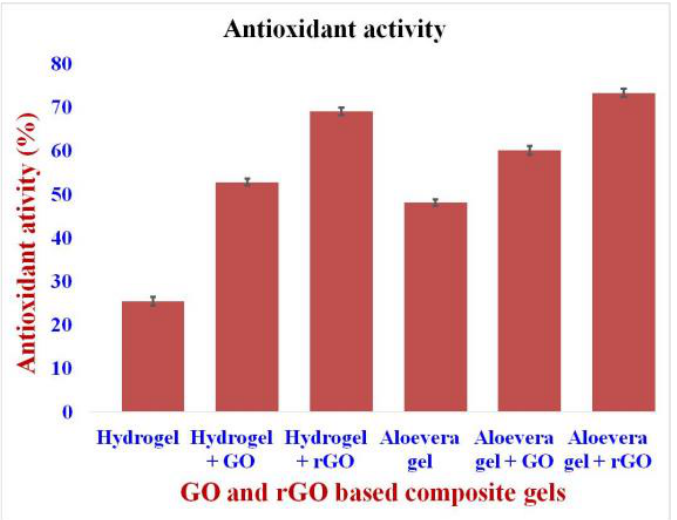
Figure 8. Antioxidant activity of GO and rGO-based Composite Gels. The antioxidant activity of the formulations was carried out using a DPPH assay. rGO-based hydrogel and aloe vera gel (hydrogel + rGO and aloe vera + rGO) showed a high percentage of antioxidant activity.